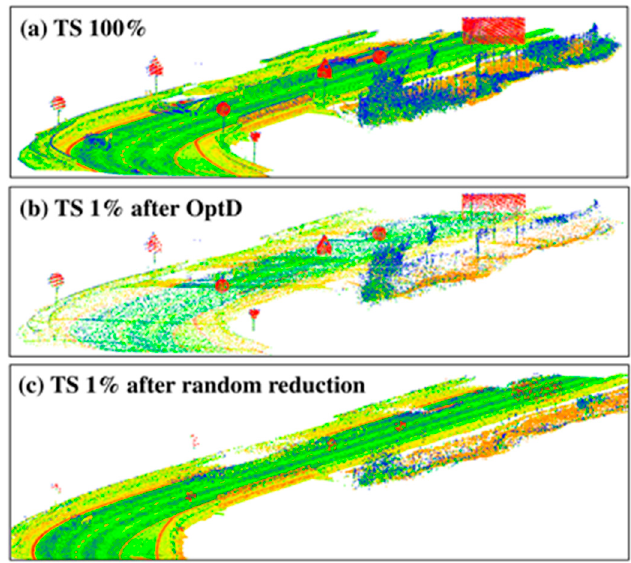
Figure 7. Point cloud of TS: ( a ) original, ( b ) after OptD method, ( c ) after random reduction.